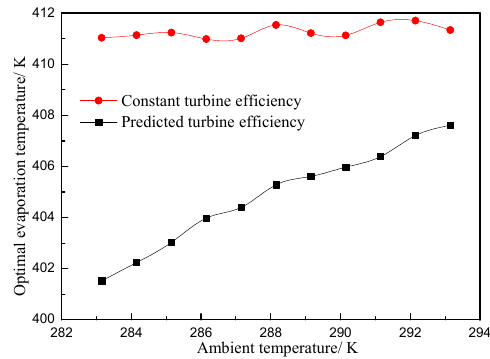
Figure 15. Optimal evaporation temperature at different ambient temperature.